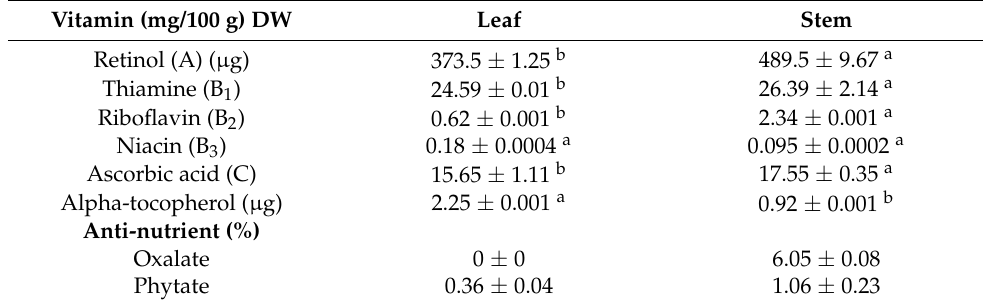
Table 2. Vitamin and anti-nutrient content in the leaf and stem of H. odoratissimum .